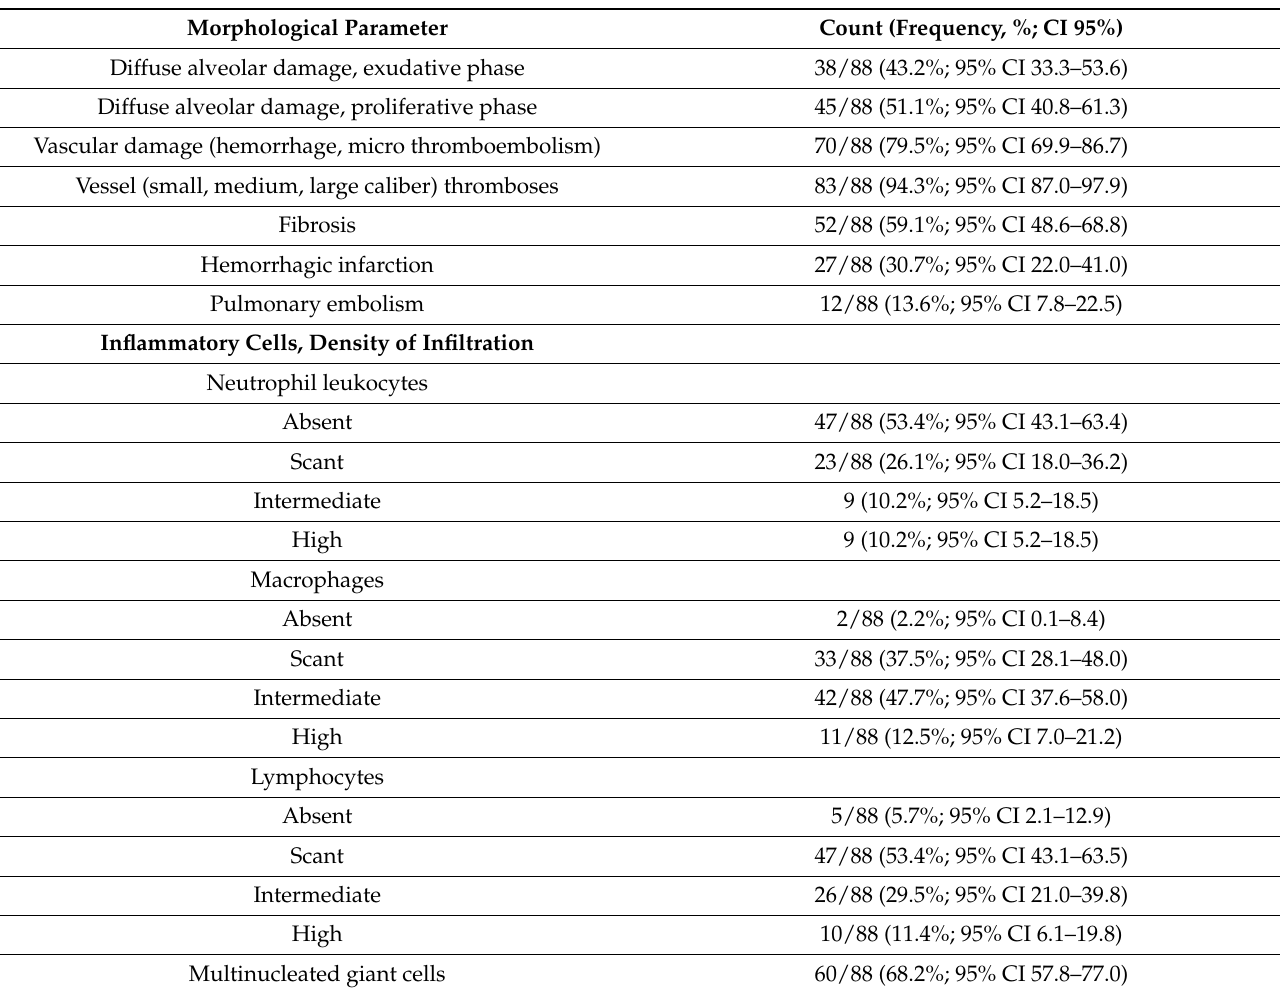
Table 2. Summary of morphological findings in lung tissue samples. Morphological